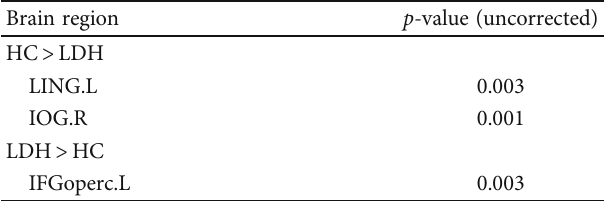
Table 4: Brain regions with signi fi cant di ff erent e ffi ciency of a given node between LDH induced nerve root(s) compression and healthy control